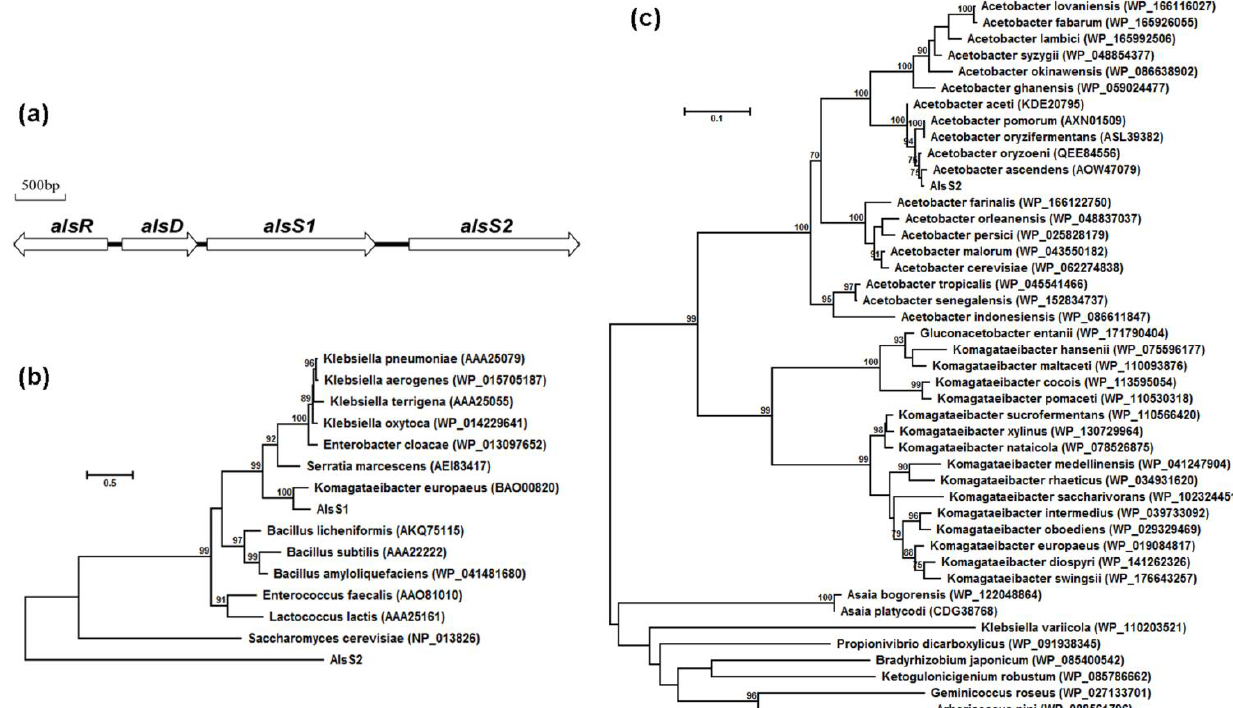
Figure 1. The gene cluster related to acetoin biosynthesis in A. pasteurianus CICC 22518 ( a ), phylogenetic tree of AlsS1, AlsS2, and reported ALSs involved in acetoin biosynthesis ( b ), phylogenetic tree of AlsS2 and similar analogs in GenBank ( c ). The reconstruction was computed by the maximum likelihood method with bootstrapping test (1000 replicates) using MEGA X. GenBank accession numbers of the reference sequences were labeled in parentheses.